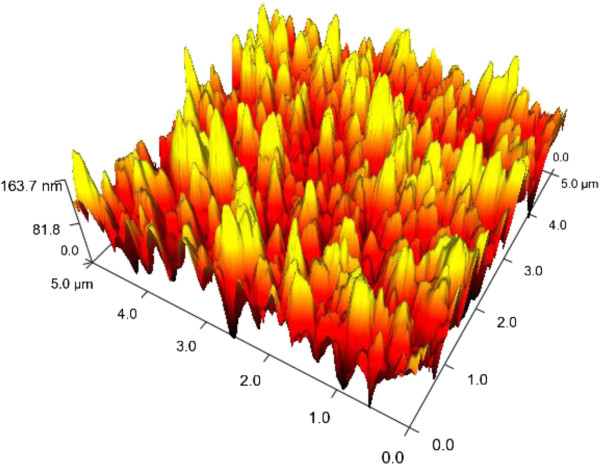
3D topological AFM image (5 × 5 μm2) of sample B.